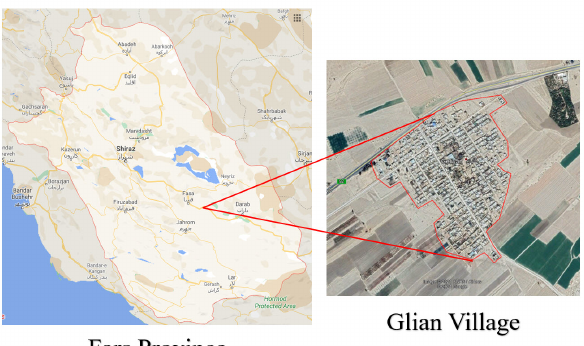
Figure 3. Location and boundary of villages of Glian in Fars province,